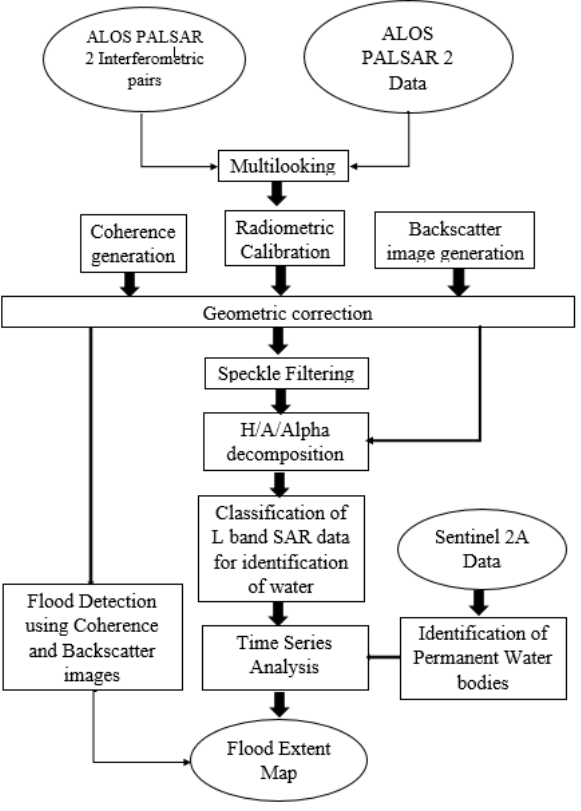
Figure 2. Process